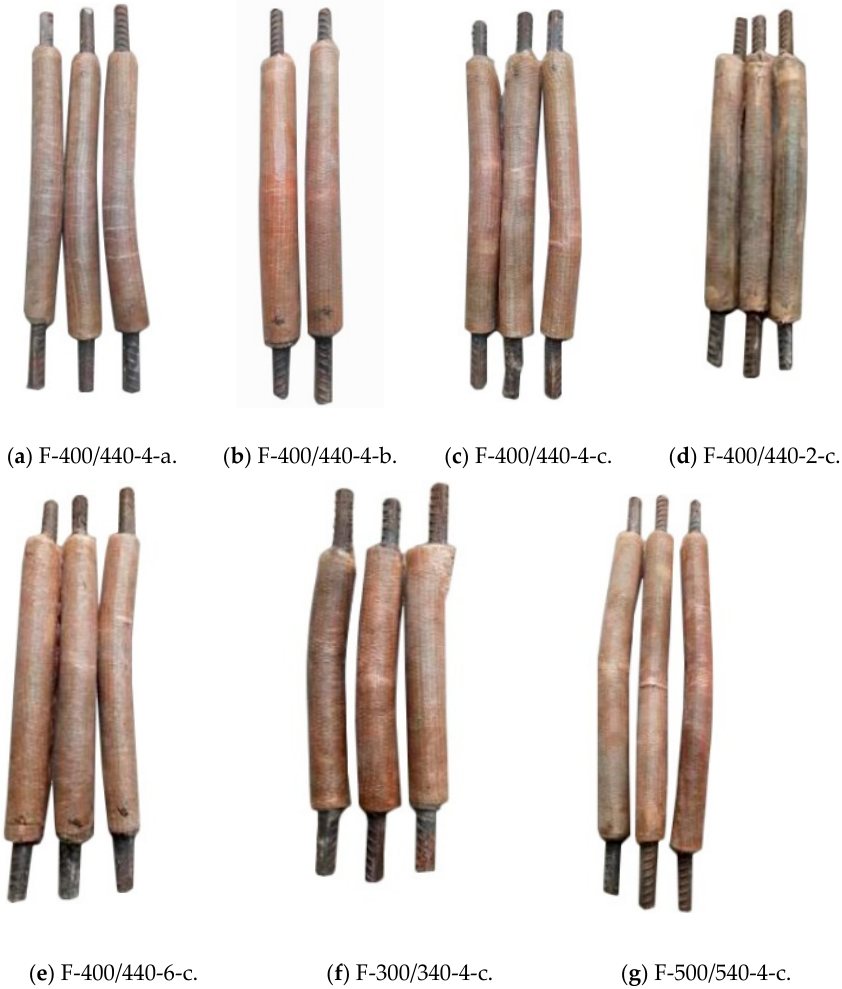
Figure 4. Global buckling failure mode of FCCC-R specimens.